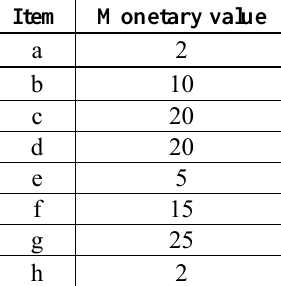
Table 2. Monetary Table